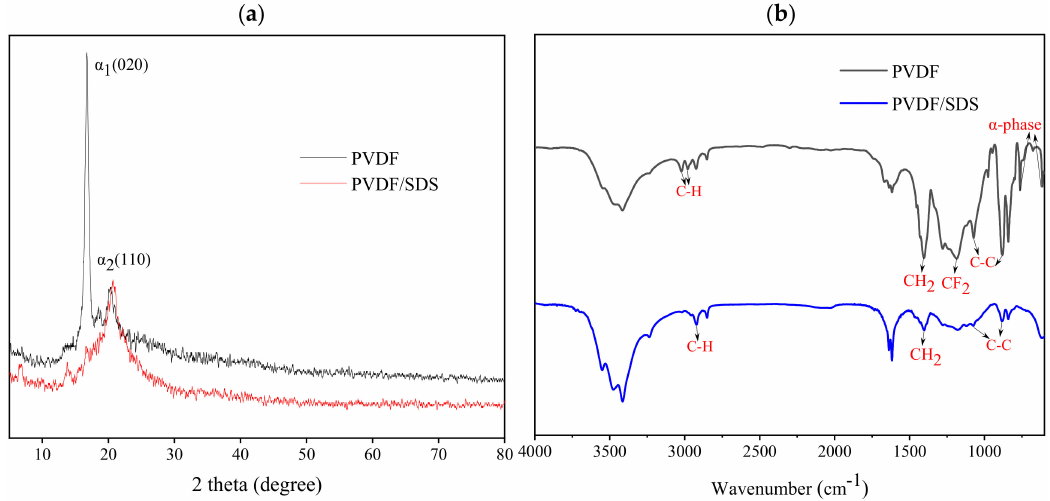
Figure 6. ( a ) XRD patterns of nanofiber membranes, ( b ) FTIR spectra of nanofiber membranes.